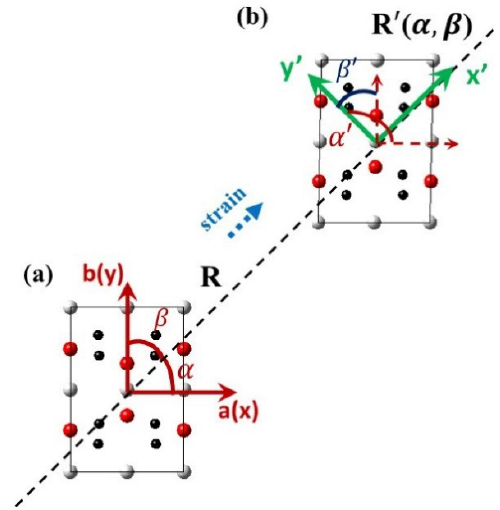
Figure 3. Diagram for ( a ) an undeformed lattice, ( b ) a deformed lattice with in-plane arbitrary uniaxial tensile strain (directional cosines ( cos α ,cos β ) ).